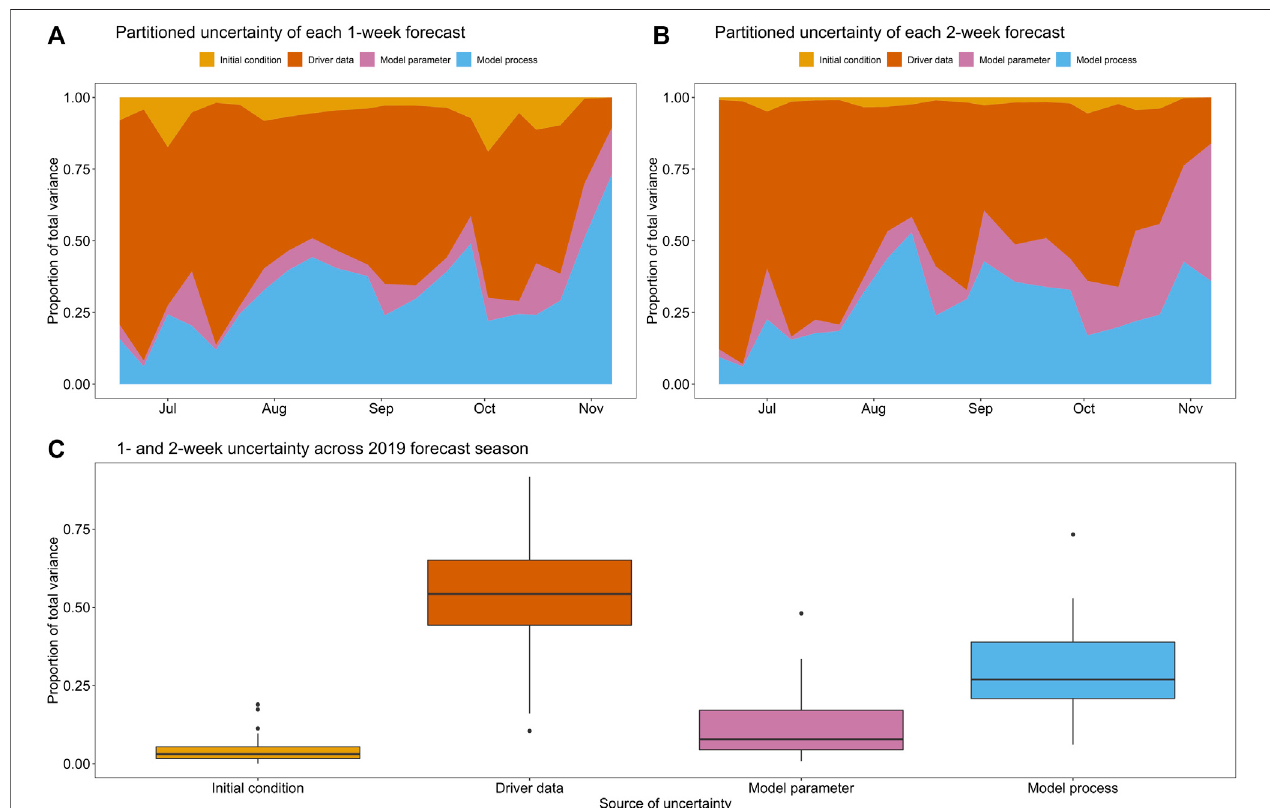
FIGURE 6 | Panel (A, B) depicts how the relative contribution of different sources of forecast uncertainty (initial condition, driver, parameter, and process) from the work fl owwithiterativemodelre fi ttingevolvedovereachforecastingcyclestartingwiththeinitialdayoftheforecastcycle1-week( A ; t +1in Figure2 ),and2-week( B ; t +2 in Figure2 )aheadforecasts.Panel (C) depictsthesamesourcesofuncertaintyaggregatedacrossalloftheforecastcyclesfrom t +1and t +2thatwereevaluatedduring the 2019 forecast period.